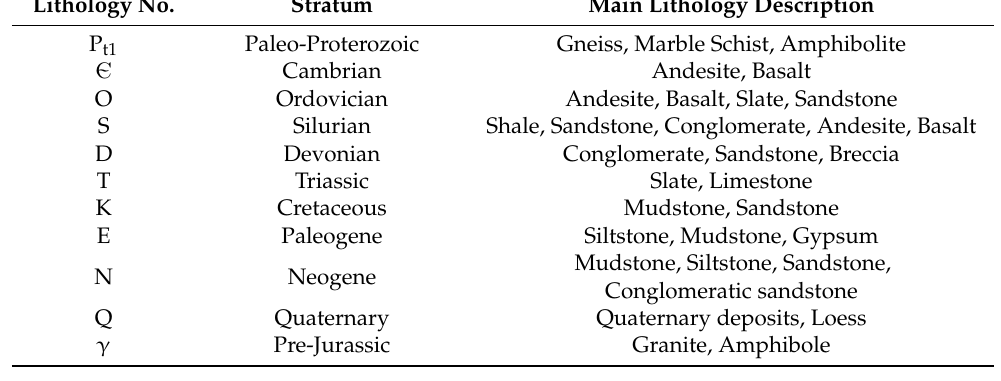
Table 2. Descriptions of categorized lithology in the study area. Lithology No.